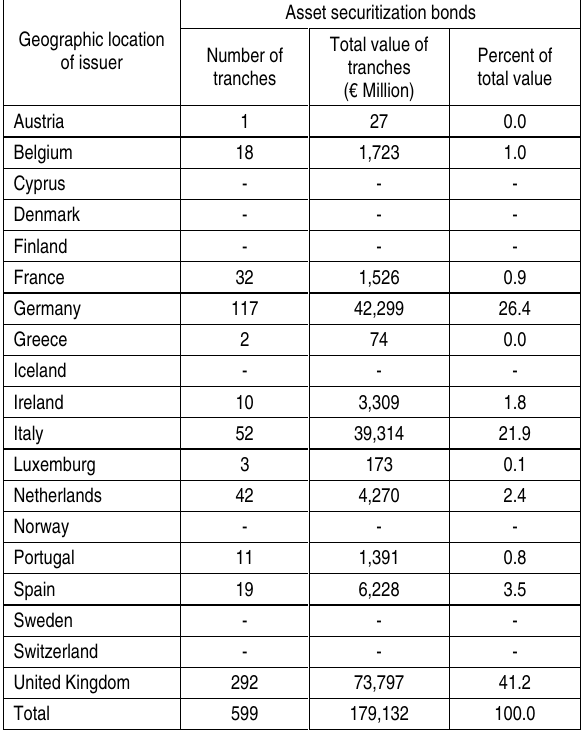
Table 3. Geographic distribution of